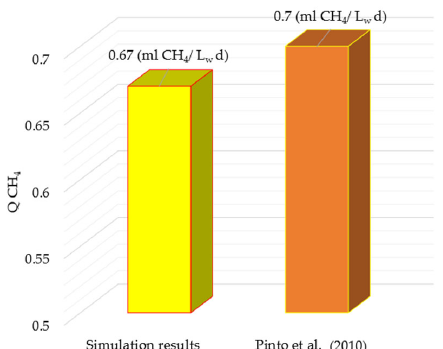
Figure 4. The daily methane production rate (MFC) per litre of wastewater